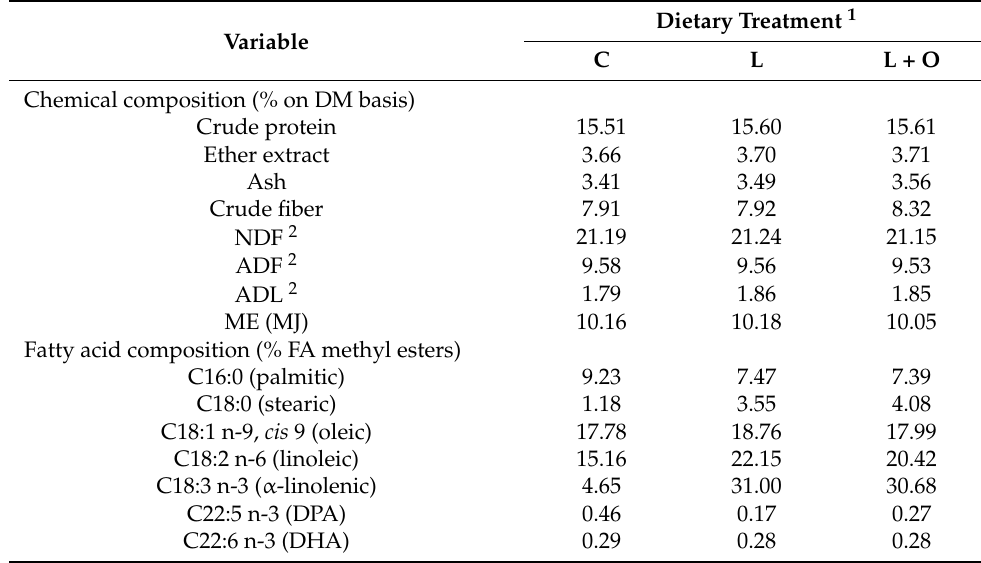
Table 2. Chemical and fatty acid composition of